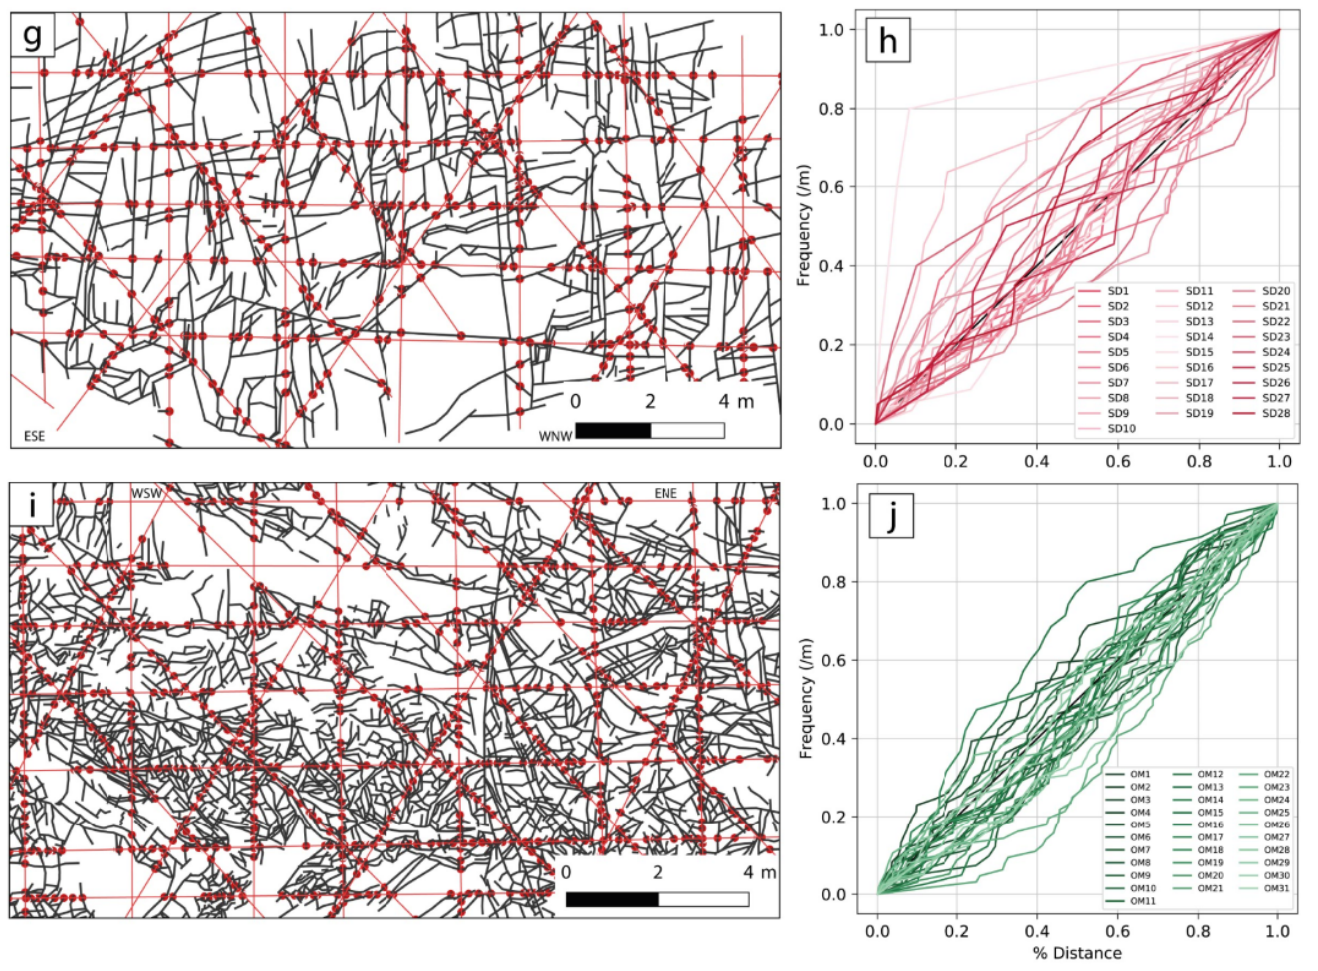
Figure 9. Clustering of the fracture network in the Odenwald. ( a ) Fracture map from the granodioritic Lichtwiese (LD) damage zone, ( b ) Distance-occurrence frequency diagram associated with mapping. ( a , c ) Fracture 2D profile in a faulted gabbro (Mühltal (MUL)). ( d ) Distance–occurrence frequency diagram associated with mapping, ( c , e ) Fracture 2D profile in a faulted granodioritic Weschnitz pluton, in Heppenheim quarry (HP), ( f ) Distance–occurrence frequency diagram associated with mapping, ( e , g ) Fracture 2D profile in the granitic Tromm pluton (Streitsdölle (SD)), ( h ) Distance–occurrence frequency diagram associated with mapping, ( g , i ) Fracture 2D profile in an amphibolite outcrop in Obermengelbach (OM), ( j ) Distance–occurrence frequency diagram associated with mapping ( i ). For maps and profiles ( a , c , e , g , i ), black lines represent the digitised fractures, and red lines and dots the artificial scanlines used to compute clustering features. The applied colour code in the distance–occurrence frequency diagrams in ( b , d , f , h , j ) is related to the sampled lithology (see Figure 1).